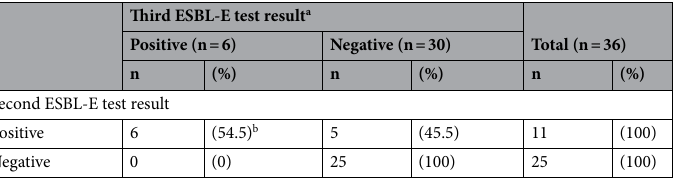
Table 5. Changes in ESBL-E carriage statuses from the second testing to third testing (n = 36; Analysis Part 2). ESBL-E, extended-spectrum β-lactamase-producing Enterobacteriaceae. a Performed ≥ 12 months after the second ESBL-E testing. b 95% confidence interval: 24.6% to 81.9%. The 2.5th and 97.5th percentiles were used to express 95% confidence